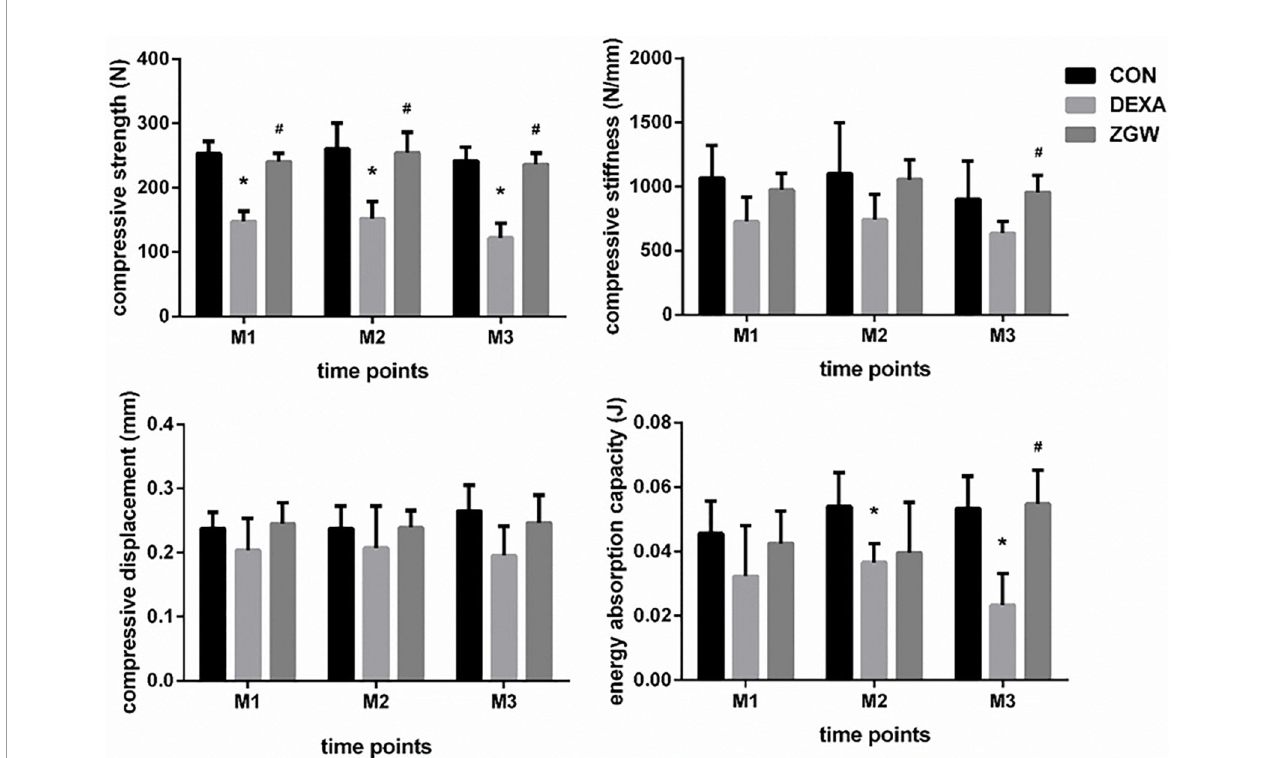
FIGURE 2 | Results of biomechanical analysis of L2. Data are the means ± SD. * p < 0.05 vs. CON group; # p < 0.05 vs. DEXA group.